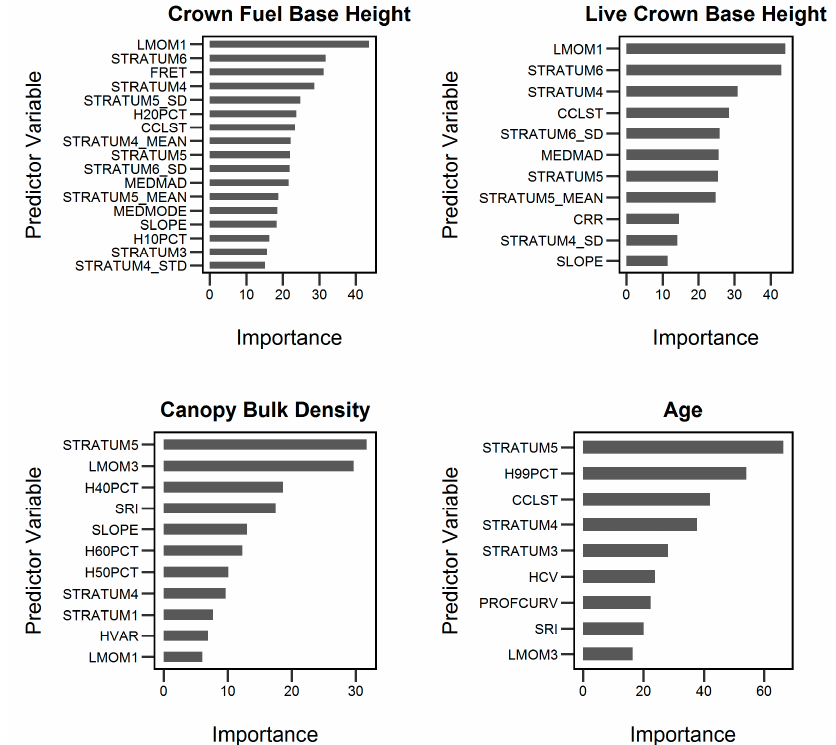
Figure 2. Variable importance plots from the randomForest models of crown fuel base height, live crown base height, canopy bulk density, and stand age. The “importance” measure on the x-axis represents the normalized difference mean squared error.